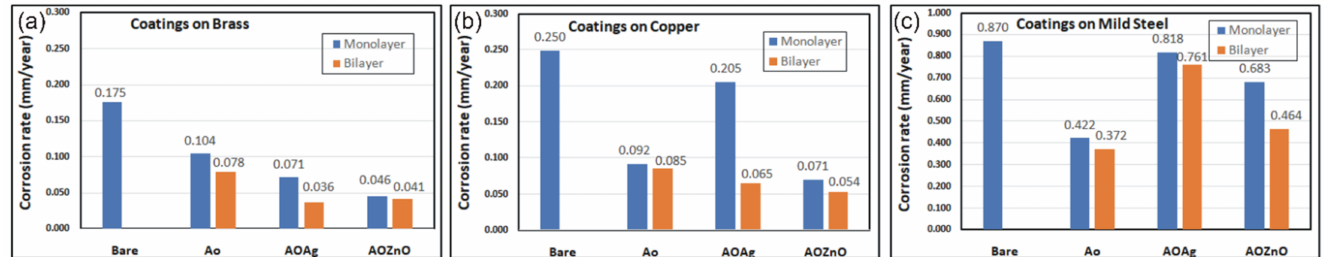
Figure 8. Evolution of the corrosion rate after the metallic surfaces modification: ( a ) brass, ( b ) copper, ( c ) mils